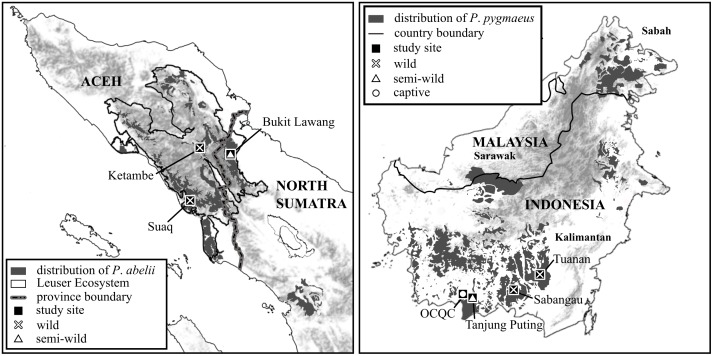
Geographical distribution of Pongo abelii and Pongo pygmaeus on Sumatra and Kalimantan, respectively, with sampling areas highlighted.